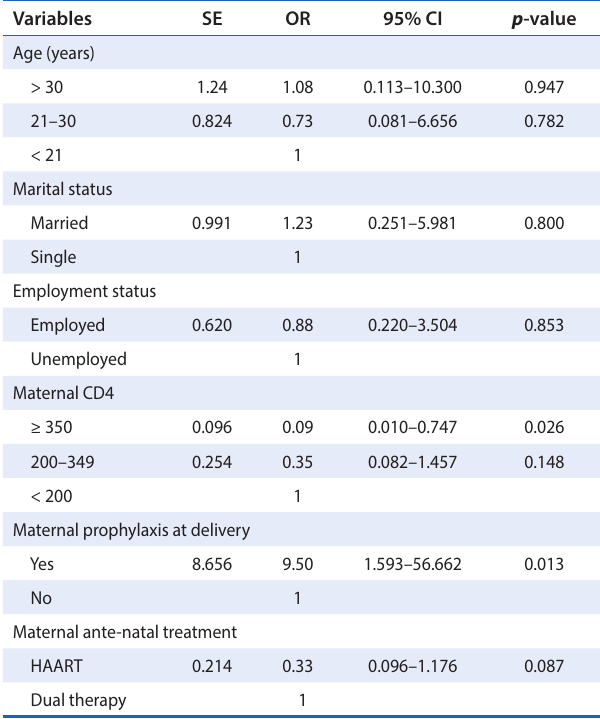
Table 2: Bivariate analysis of the associated factors of MTCT ( n = 206) Table 3: Logistic regression (LR method) analysis of MTCT ( n =